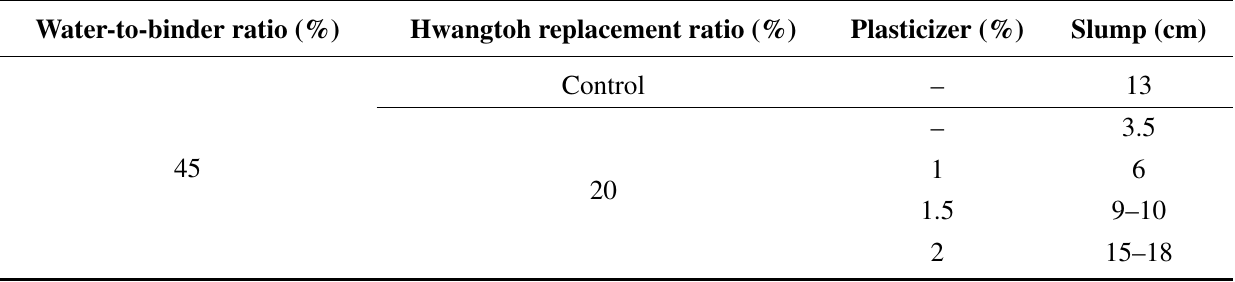
Table 2. Slump test results.